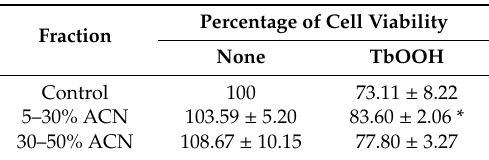
Table 1. Percentage of viability (MTT test) in Caco-2 cells in the presence of the isolated 5–30% and 30–50% acetonitrile (ACN) fractions. Means of at least three experiments (eight replicates for each experiment) were compared with the treated control. (* p <